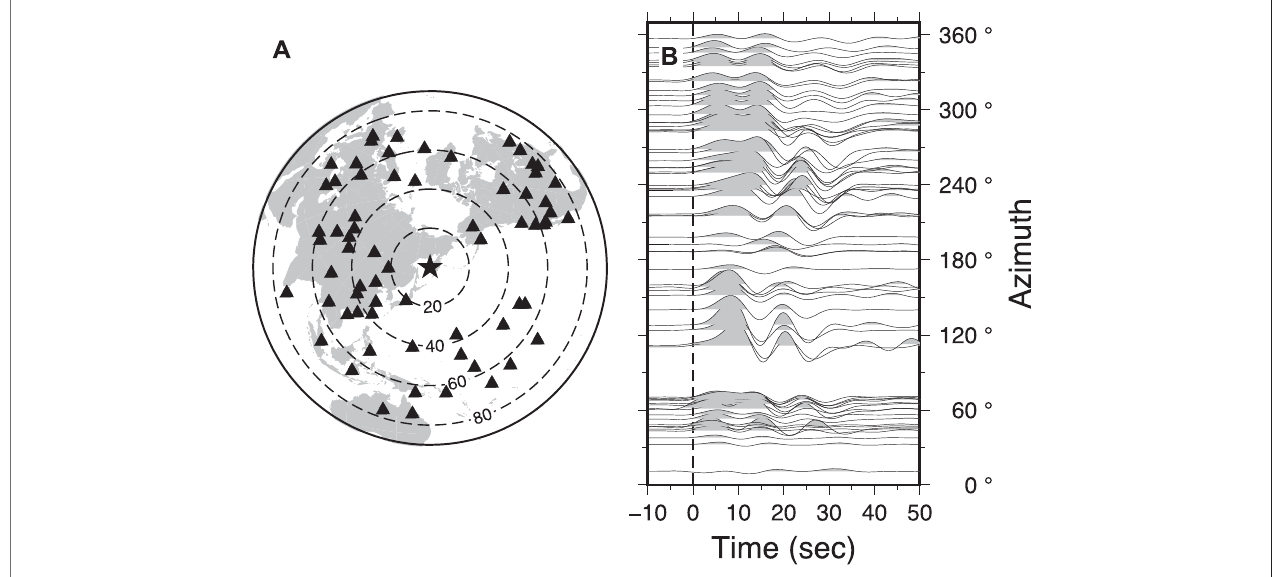
FIGURE 2 | Station distribution and seismic waveforms using in the multi-subevent inversion. (A) GSN station distribution and (B) P -waves aligned with the fi rst arrivals (vertical dashed line). Stations at the GSN in the epidistance range of 20 o – 80 o are used in the inversion. Triangles represent the GSN stations and the star indicates the epicenter of the earthquake. Polarities of the waveforms with azimuths greater than 180 o are reversed.